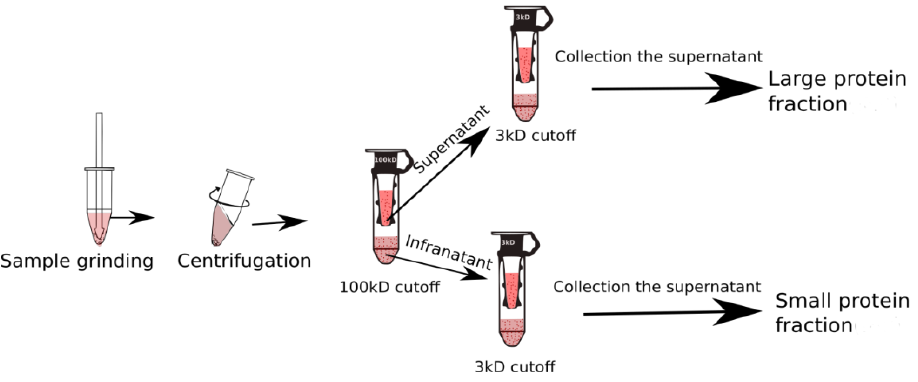
Figure 1. Schematic representation of the separation process used in the current study using the ff base membrane cut-off base principle. membrane cut-o